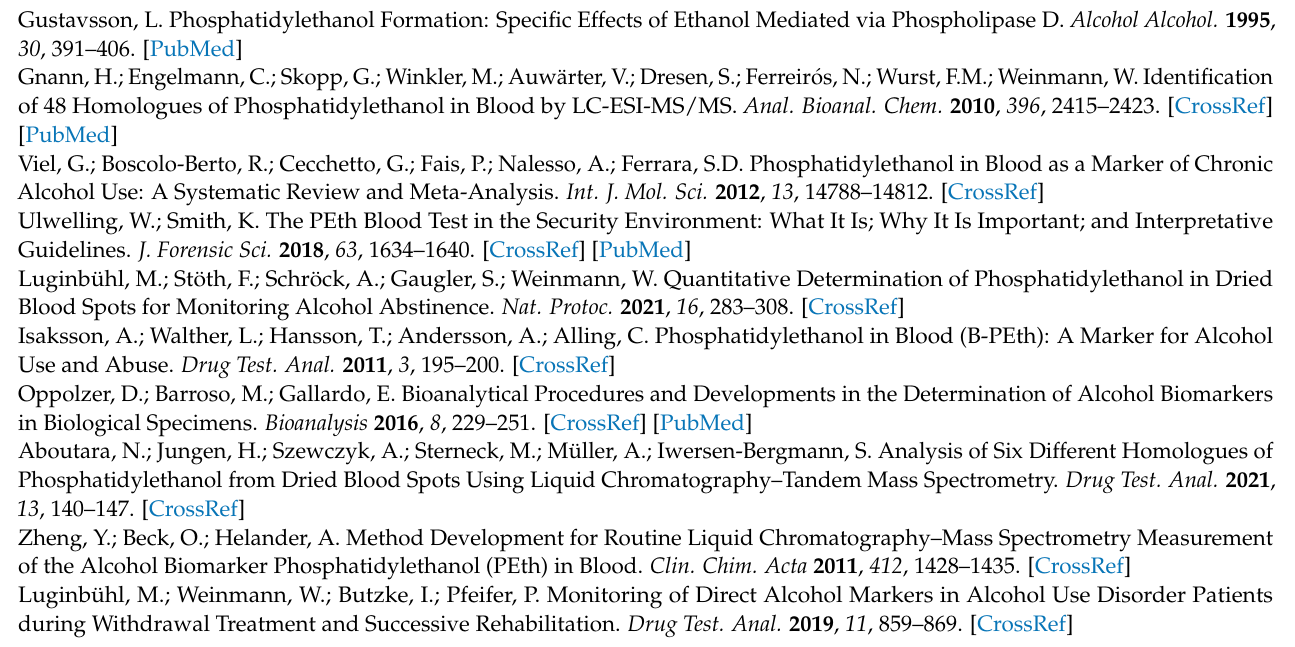
Table S3: method validation II; Table S4: quantitation PEth 16:0/18:1 in DBS, which was drying in ethanol